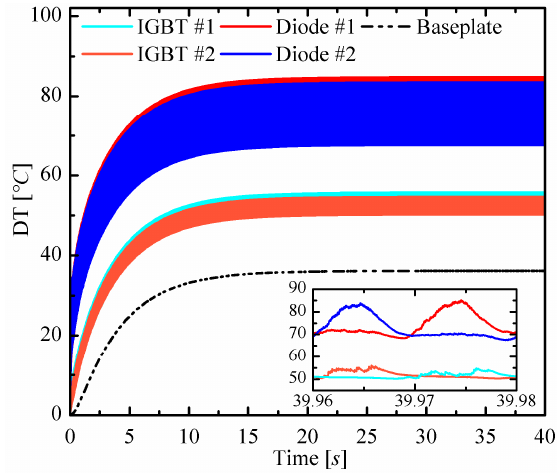
Figure 8. Self and mutual thermal impedances obtained by applying a unit power step on IGBT #1 to the module mounted on a 0.2 K/W heatsink; comparison between standard FEM and DCTM results.